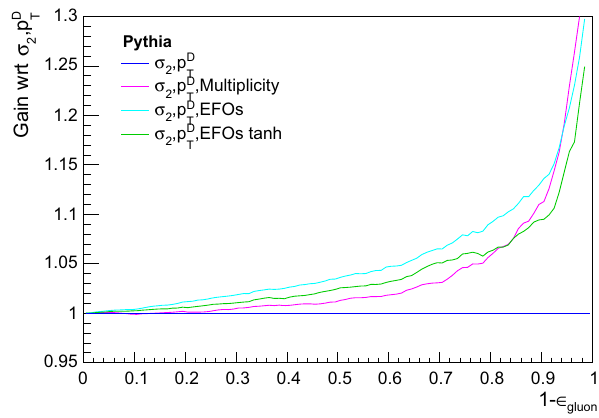
Fig. 6 Left: the relative gain for the three-variable taggers with respect toabaselinetaggerusingjust p T D and σ 2 ,fortheHerwigevents(which yieldmoreconservativediscriminationestimates).Thegainisalsoplot- ted for EFOs computed with the hyperbolic tangent fitting function